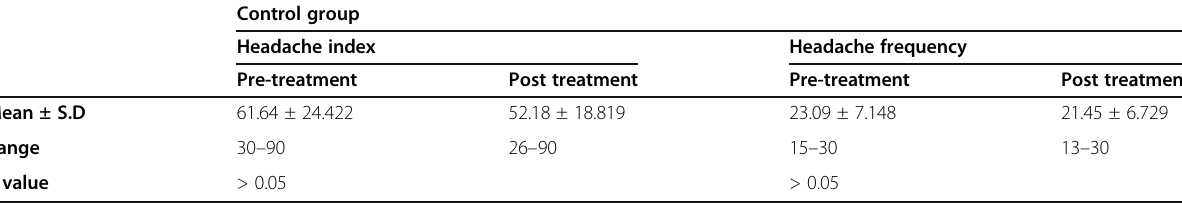
Table 4 Comparison of headache frequency and index before and after treatment within the control